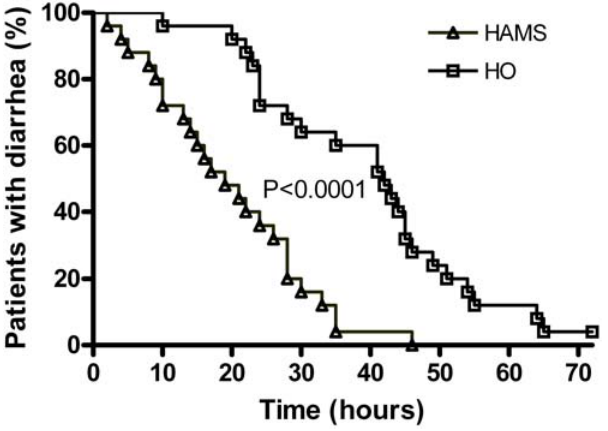
Figure 2. Recovery from diarrhea shown as residual proportion of patients with diarrhea at each time point after commence- ment of ORS. The difference between high amylose maize-ORS (HAMS) and hypo-osmolar-ORS (HO) was statistically highly significant (P , 0.0001, log-rank test).